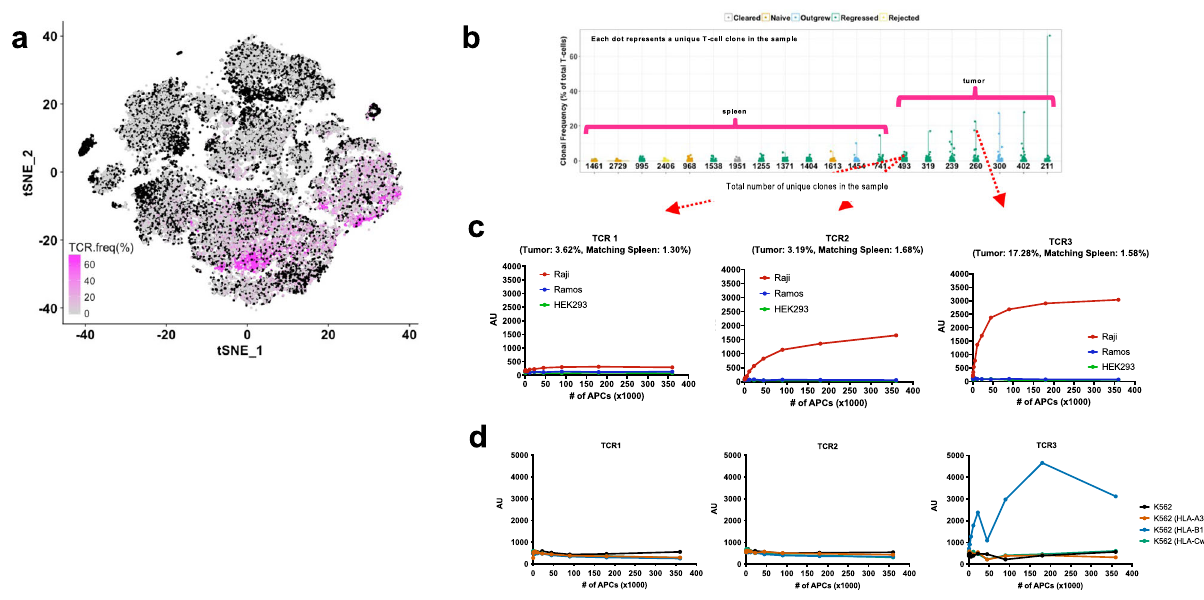
Fig. 5 TCR frequency and clonality. a The splenic T cells and tumor-in fi ltrating lymphocytes (TILs) were sorted. Raji-speci fi c TCRs in expanded T cells were identi fi ed using TCR repertoire sequencing data. The t-SNE plot depicts TCR frequency in splenic and tumor T cells from 13 regressors. b The number of unique clones from the 13 regressors is depicted by a violin plot. c Four clonotypes from two regressors tumors were cloned into a Jurkat-luciferase reporter line. The activity against Raji, Ramos and HEK293 is shown from two of the TCR clones. d Luciferase assay was used to explore the reactivity of the TCR clones to Raji HLA ’ s: A3, B15, and